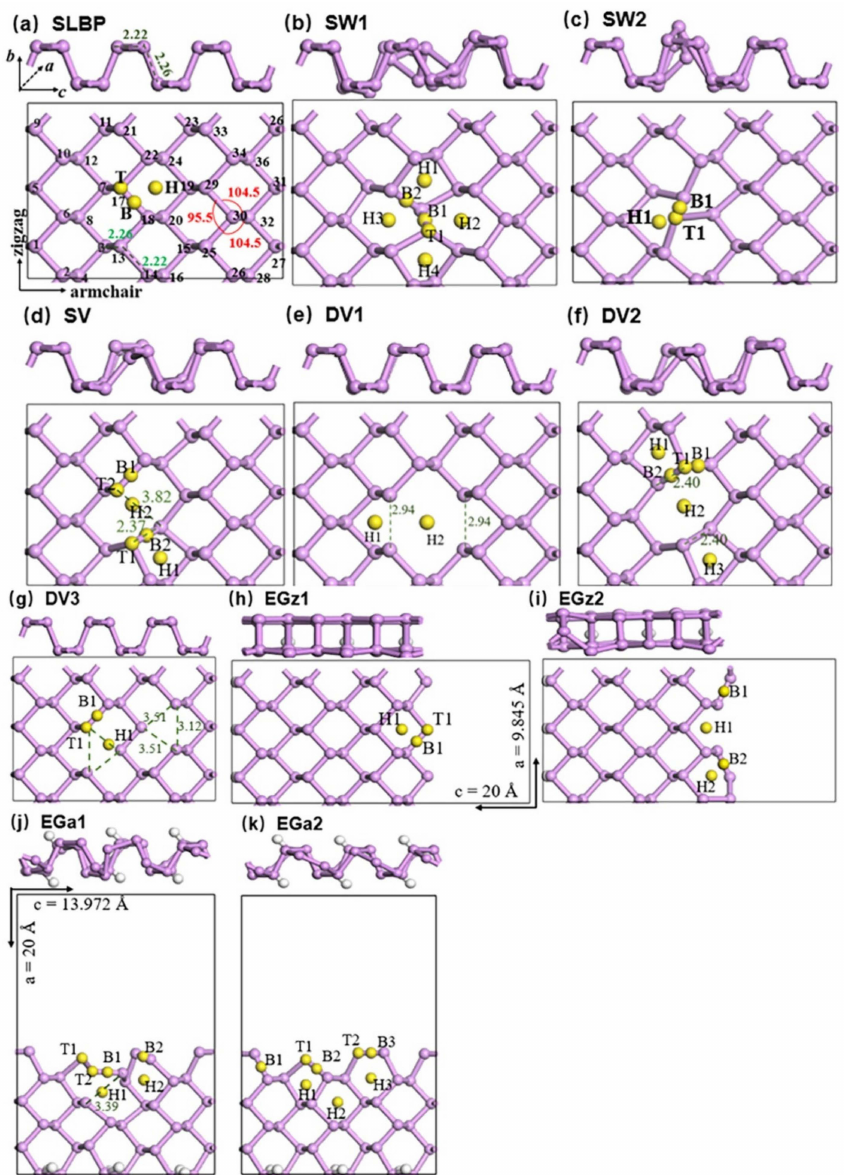
Figure 1. Side and top views of fully optimized geometries of SLBP and d-SLBP: ( a ) SLBP, ( b ) SW1, ( c ) SW2, ( d ) SV, ( e ) DV1, ( f ) DV2, ( g ) DV3, ( h ) EGz1, ( i ) EGz2, ( j ) EGa1 and ( k ) EGa2. T, T1, T2: top sites; B, B1–B3: bridge sites; H, H1–H4: hollow